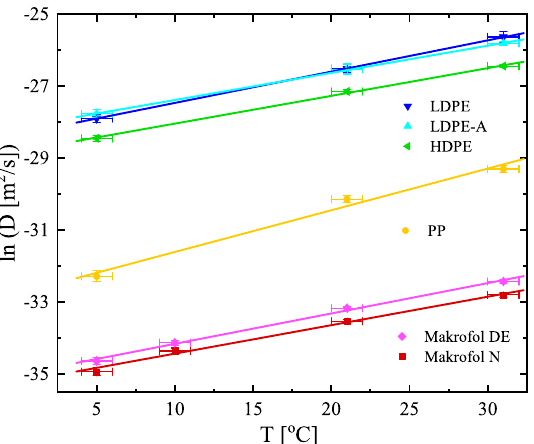
Figure 5. Temperature dependence of the diffusion coefficients of the studied materials. Note that the dependence is ln( D ) vs. T . The points are the experimental data and the solid lines are linear fits of the data. The uncertainties are at the level of 1 σ .